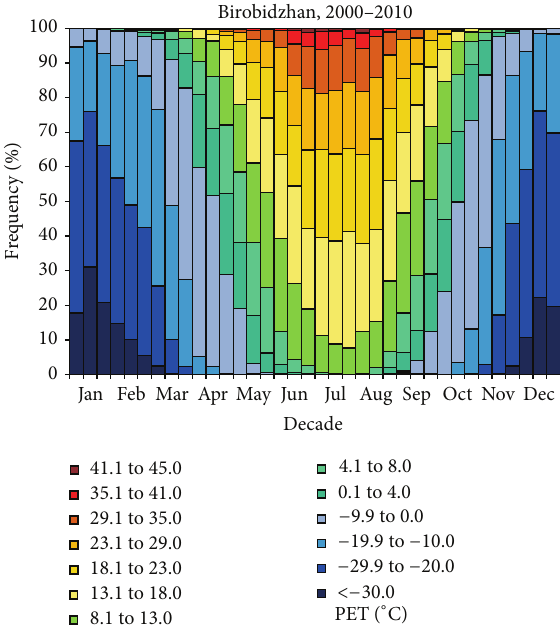
Figure 5: Mean frequency distribution of PET values in Biro- bidzhan, zone 2, during the year divided into 10-day intervals (decades) for the period 2000–2010.